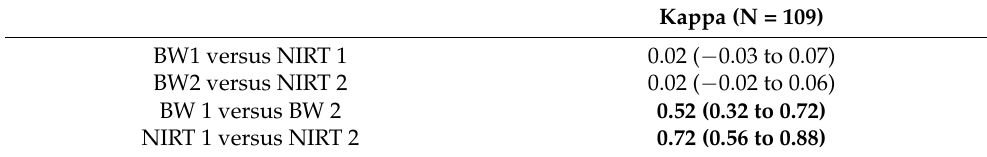
Table 4. Cohen’s kappa coefficients with 95% confidence intervals, between methods, and within methods. (Near-infrared transillumination (NIRT), and bitewing radiographs (BW)). The most relevant results are in bold. Surfaces with one missing, filled, non-interpretable image at any point were excluded.